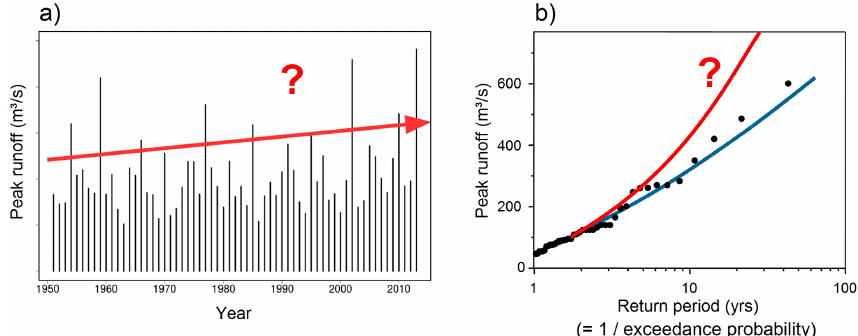
Figure 1. (a) A hypothetical river flood time series. Each bar is the maximum annual peak runoff, and the red arrow indicates an increase in hazard. (b) Flood frequency plot. Each point is the maximum annual peak runoff plotted against its exceedance probability (expressed as its inverse, the return period). The fitted blue line reflects the past situation and the red line a potential increase in river flood hazards. “Hazard” is defined as the exceedance probability of a river flood level that potentially causes damage.